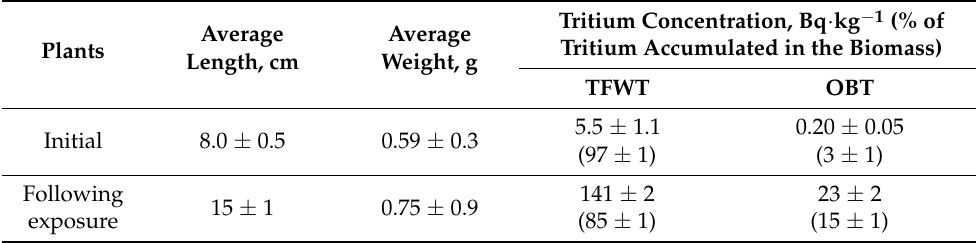
Table 1. Results of tritium content estimation and its distribution with regard to the forms of binding to the Elodea biomass ( n = 10, p = 0.95).